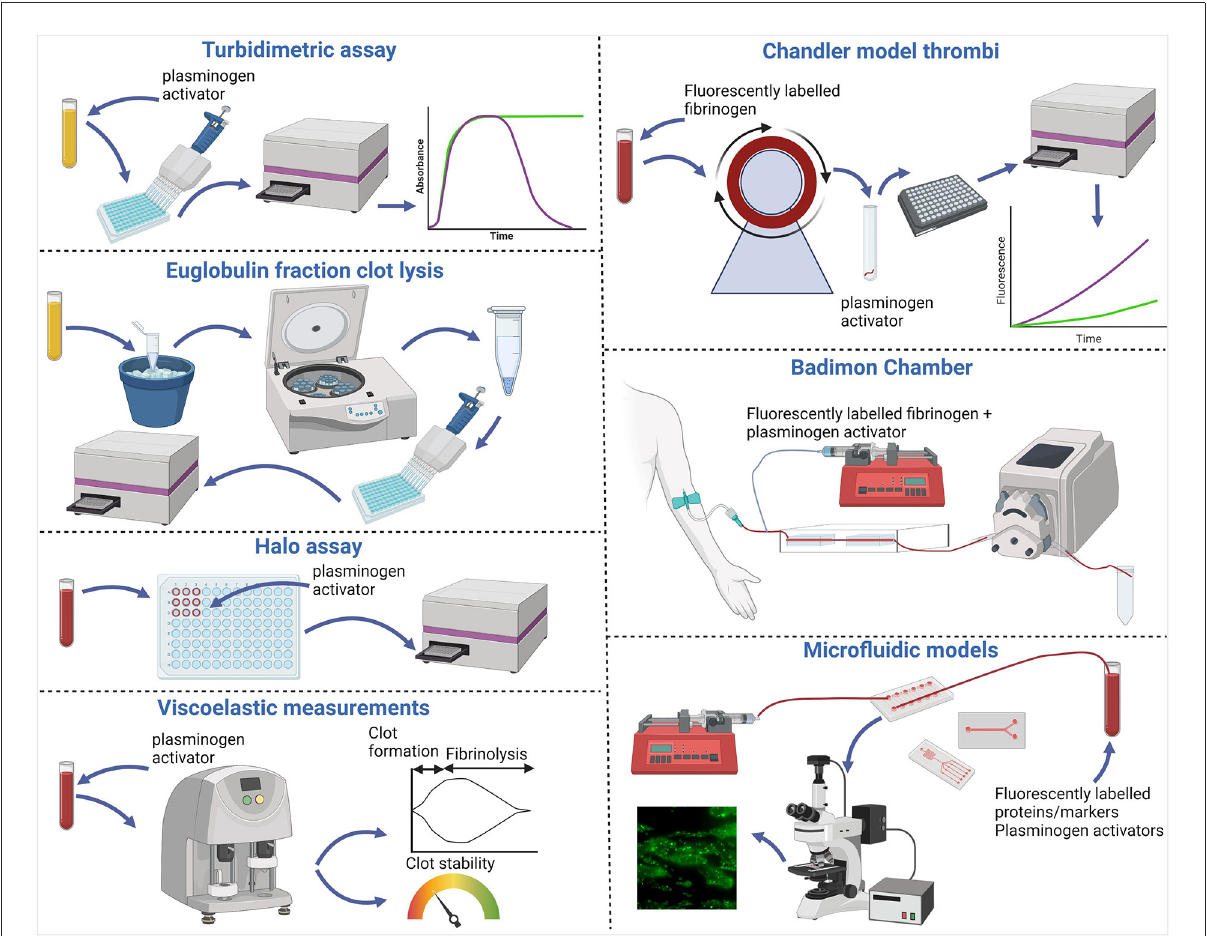
FIGURE1 Fibrinolytic assays and models. Turbidimetric clot lysis assays involve clotting plasma in 96 well plates with the addition of calcium and thrombin in the presence of plasminogen activators. Change in absorbance is then measured using a spectrophotometer, increasing as clots form and decreasing during fibrinolysis. The Euglobulin fraction containing plasminogen, plasminogen activators and fibrinogen can be isolated by precipitation on ice cold acetic acid and collected via centrifugation. The pellet is then washed and solubilized before clotting with